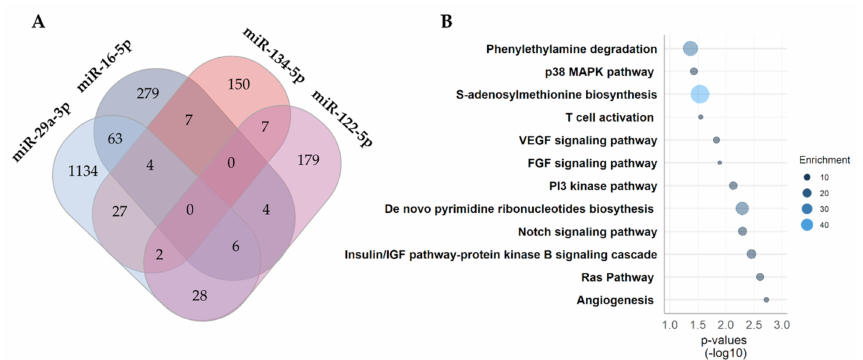
Figure 4. Predicted targets and pathway enrichment analysis. Predicted targets of the four differ- entially expressed miRNAs associated with GDM. ( A ) Venn diagram of predicted targets identified through TargetScan v.7.2. (human). ( B ) Enrichment analysis of predicted targets common to two or more miRNAs. The size and the color of the circle corresponds to the fold